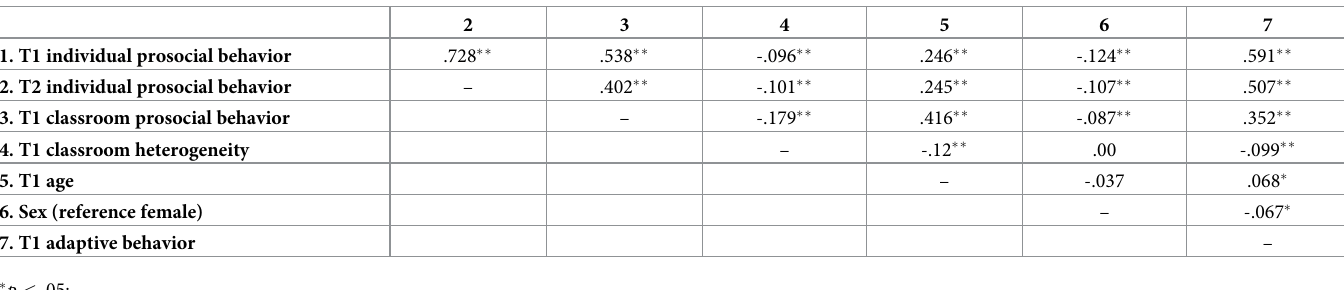
Table 2. Correlations between the key variables.